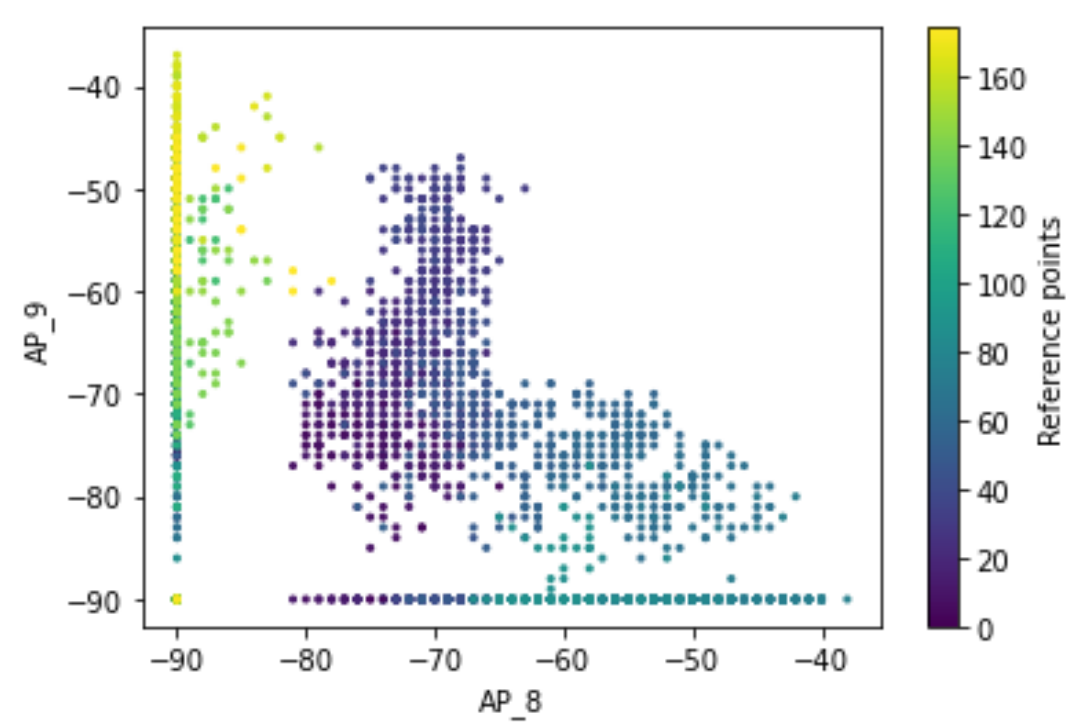
Figure 19. Distributions of RSS for Pair Wi-Fi APs of AP_8 and AP_9 for dataset_B.